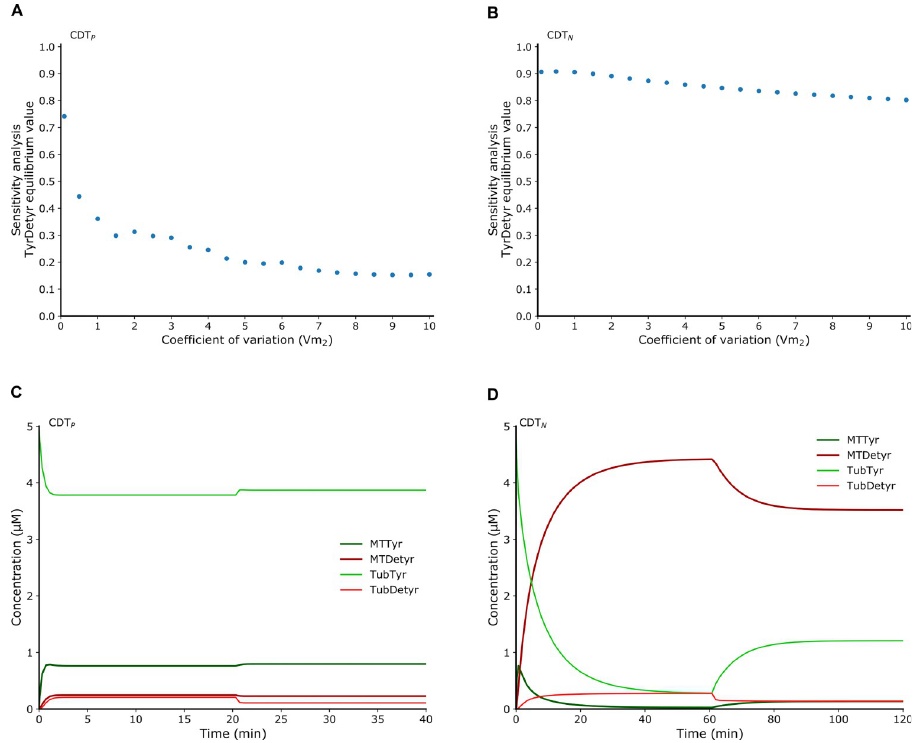
Fig 3. Mathematical model predictions of the tyrosination reaction activation in proliferative and neuronal cells explaining failures of compound screening. ( A ) Sensitivity analysis of the equilibrium value of TyrDetyr obtained for different coefficients of variation of the kinetic parameter V in the computational model CDT P , indicating a m 2 tolerance of five hundred percent for the parameter V m 2 before TyrDetyr deviates from its equilibrium state by eighty percent. The BIOCHAM command used is: sensitivity(F(G(TyrDetyr = x)), [Vm2], [x -> 10], robustness_coeff_var: c) , where c is the robustness coefficient value. ( B ) Similar sensitivity analysis in the computational model CDT N , indicating a tolerance of five hundred percent for the parameter V before TyrDetyr m 2 deviates from its equilibrium state by fifteen percent. The BIOCHAM command used is: sensitivity(F(G (TyrDetyr = x)), [Vm2], [x -> 0.065386], robustness_coeff_var: c) where c is the robustness coefficient value. (C) Perturbed numerical simulation in the model CDT P . The tyrosination rate constant V m 2 is increased at 20 units of time (min) by a factor ten. The numerical simulation shows that the tyrosination status is do not increase. ( D ) Perturbed numerical simulation in the model CDT N. The tyrosination rate constant V m 2 increased at time 60 (min) by a factor ten. The numerical simulation shows that tyrosinated species slightly increase but are not greater than detyrosinated species at steady